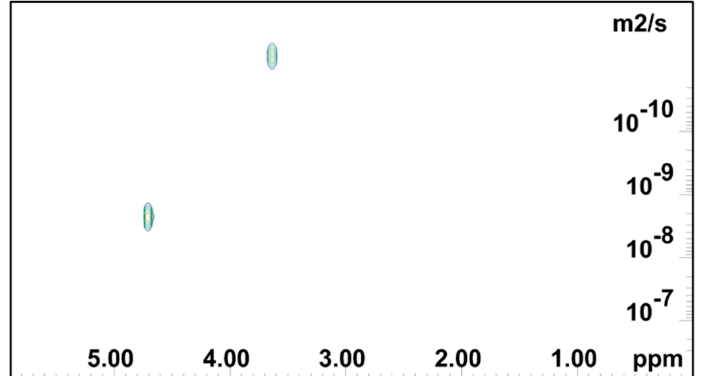
Figure 5. NMR DOSY log(D) plot for 0.2 mass % PEO gel.